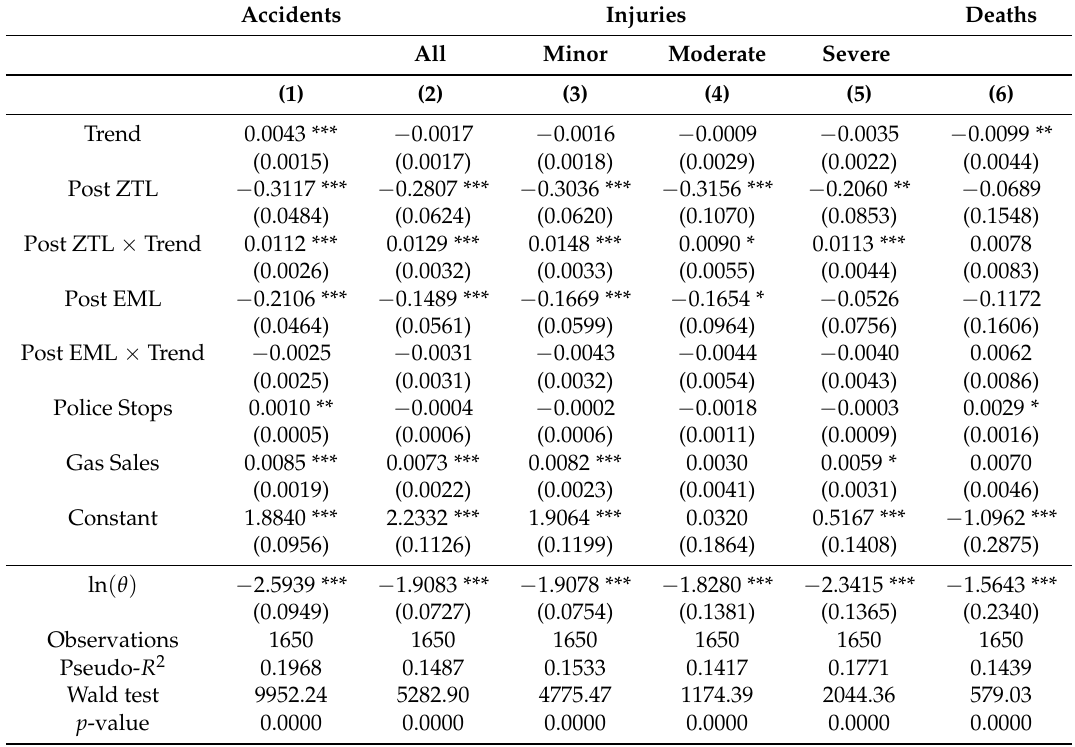
Table A3. Negative Binomial